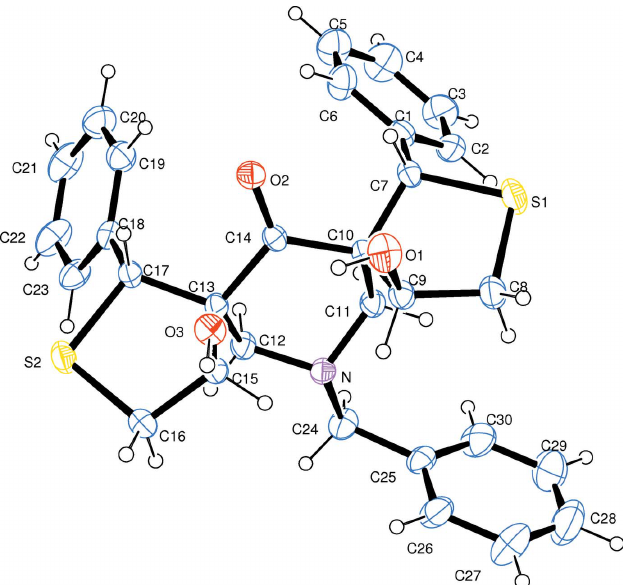
Figure 1 The molecular structure of the title compound with the atom-numbering scheme. Displacement ellipsoids are drawn at the 30% probability level. H atoms are shown as circles of arbitrary radii. The minor conformations of the two disordered phenyl rings are not shown here for